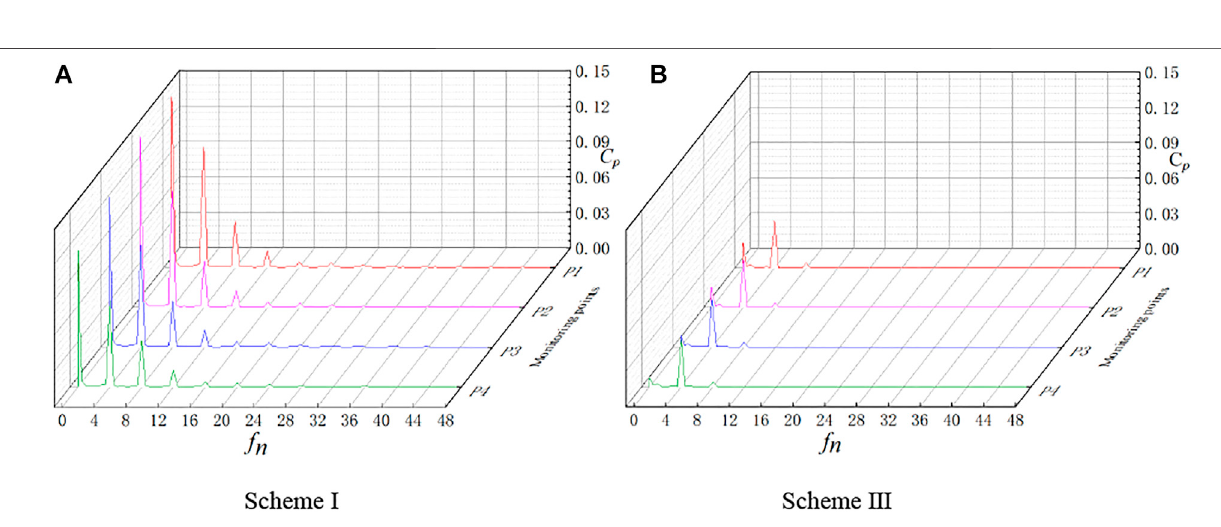
Frontiers in Energy Research |